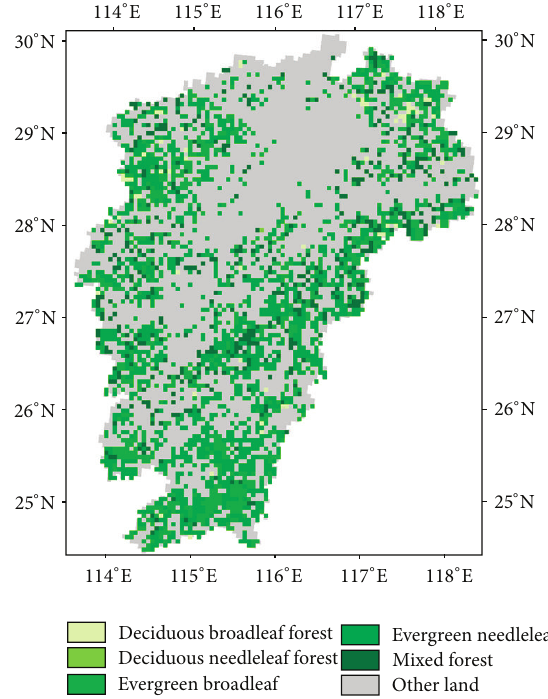
Figure 1: Forest area of Jiangxi Province in